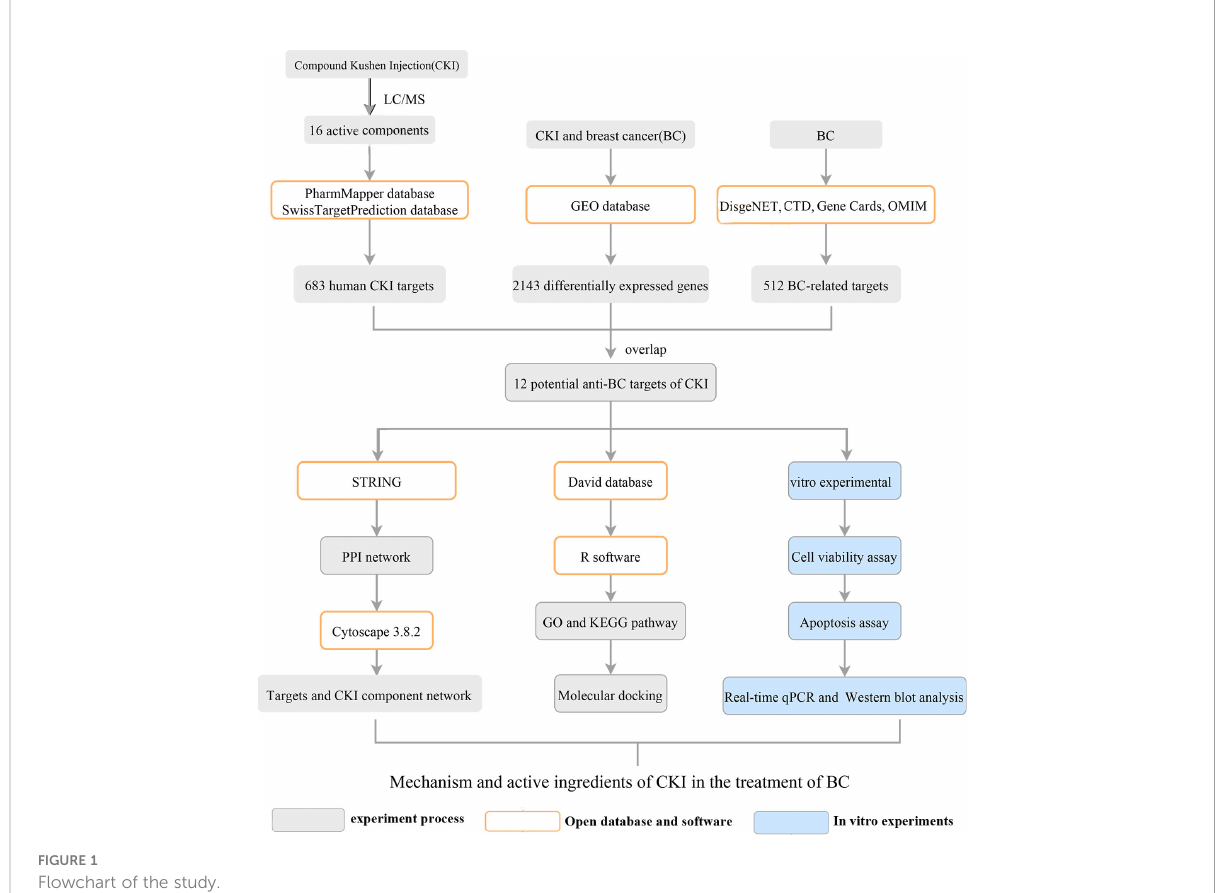
FIGURE 1 Flowchart of the